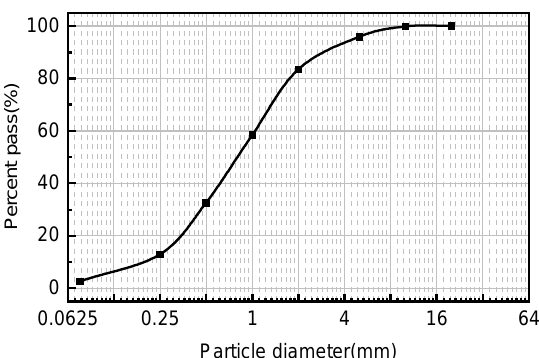
Figure 3. Particle size distribution (adapted from Zhou L et al. [29] ).